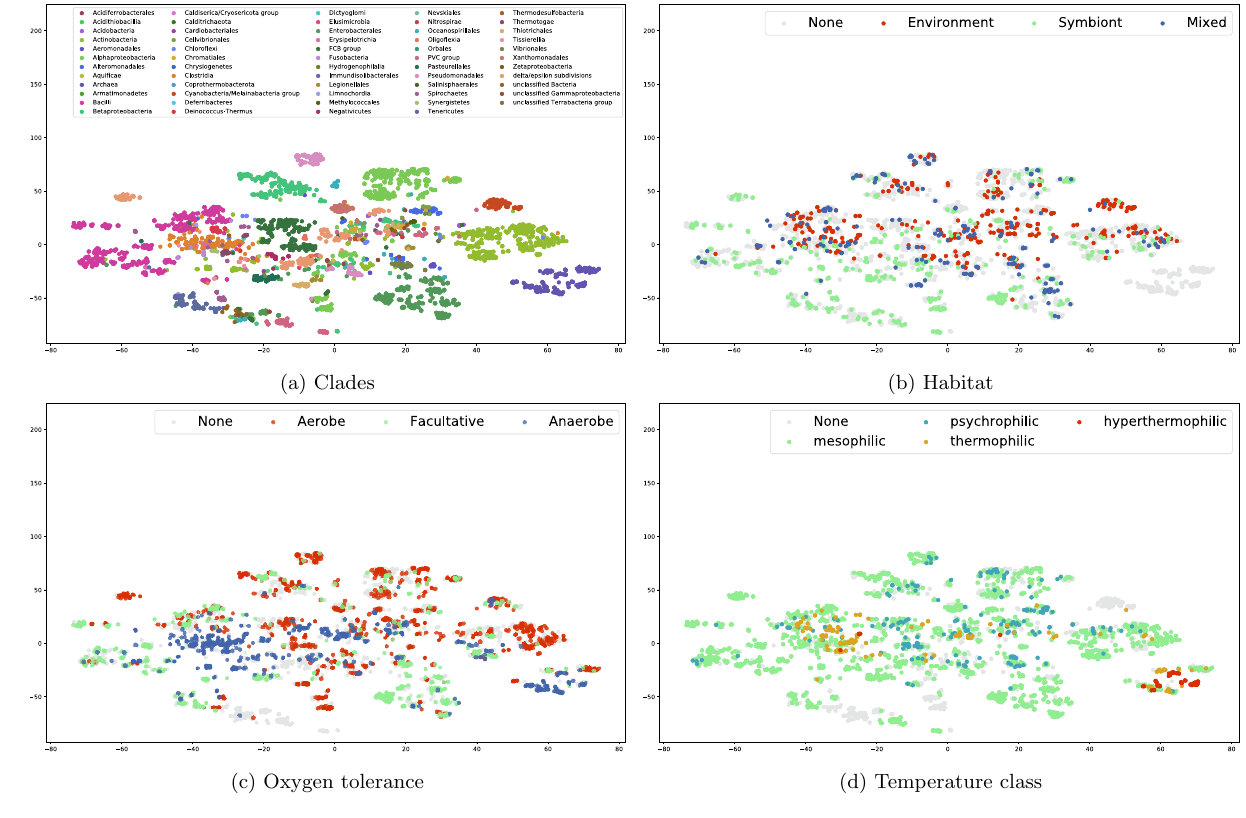
Figure 2. 2D t-SNE visualisation. Projection of the nodes in scope per species. The Jaccard distance and a perplexity of 40 were used. Each species has been coloured according to its clade ( a ), habitat ( b ), oxygen tolerance ( c ), and temperature class ( d